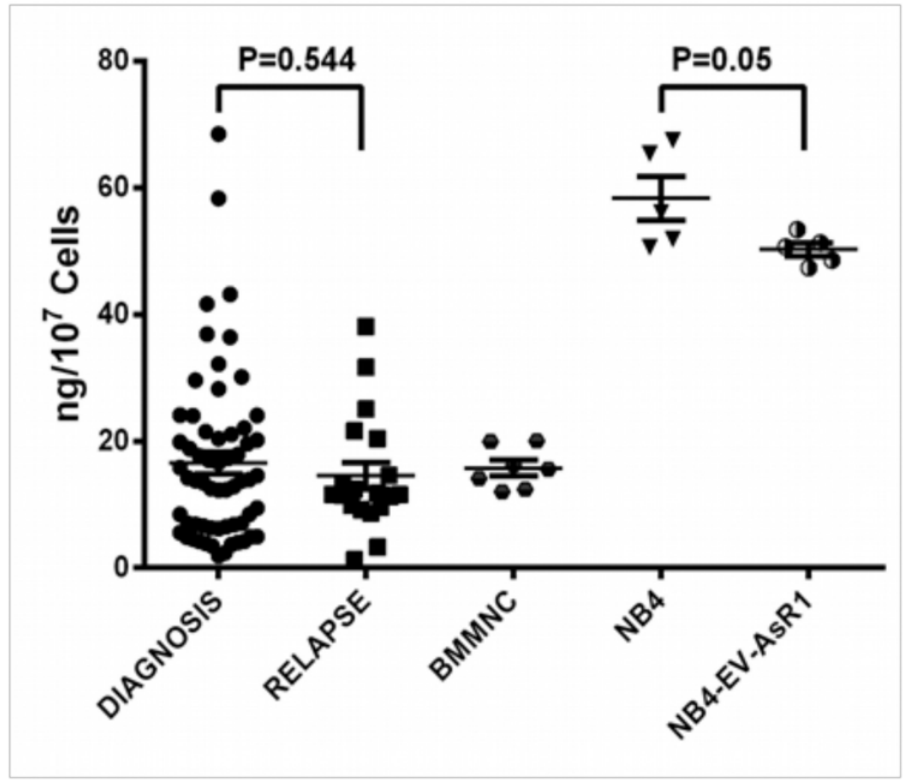
Fig 2. Intracellular arsenic levels in malignant promyelocytes of APL patients at diagnosis, relapse, in normal bone marrow mononuclear cells (BMMNC) and in NB4 cell lines. Scatter plot of the intracellular concentration of arsenic levels in newly diagnosed patients (N = 61) and relapsed patients (N = 19). The level of arsenic is expressed as nanograms (ng) of arsenic detected in 10 7 cells after 24 hr culture with 0.5uM ATO. Each value was mean of triplicates. There was no significant difference between the median values between the two groups. ATO resistant NB4 cell line NB4-EV-AsR1 (n = 6) had a median ICATO value of 53.7 ng/10 7 cells, while that of NB4 (n = 5) cells was 65.1 ng/10 7